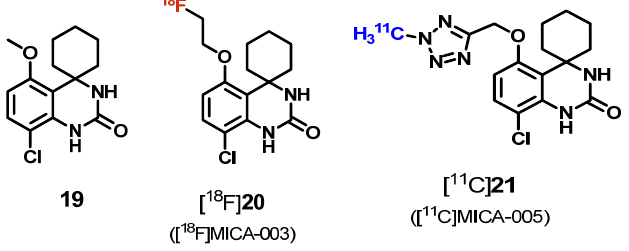
Figure 4. Figure 4. Molecular structures of PDE7A/B inhibitor 19 and 18 F- or 11 C-labeled derivatives thereof